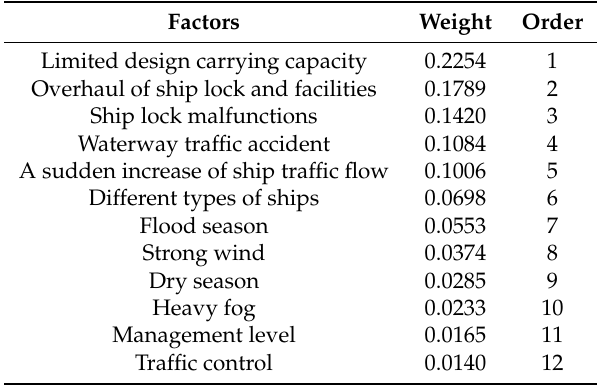
Table 6. Final weights of influencing